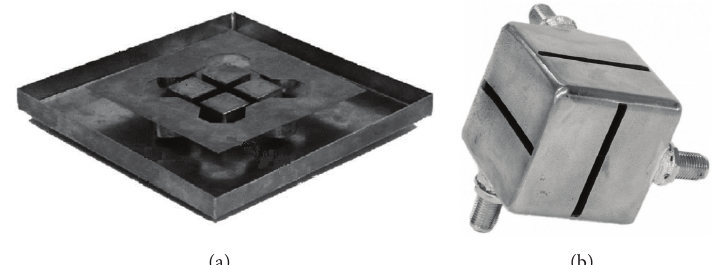
Figure 1: Conventional metallic cavity backed antennas.